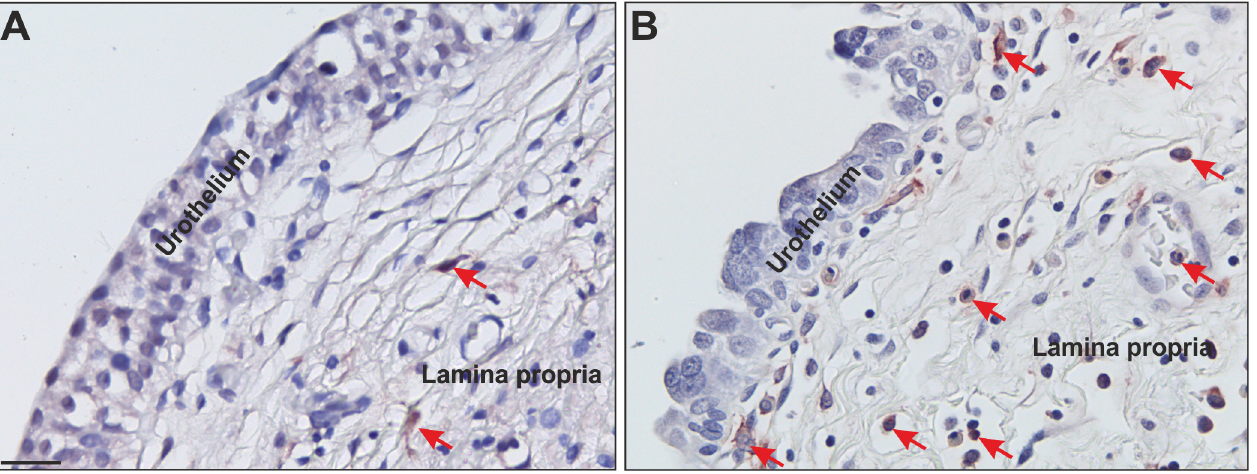
Fig 2. uPAR immunohistochemistry in bladder urothelium with inflammation and CIS, respectively. The figure shows examples of uPAR negative benign-appearing urothelium with inflammation (A) and CIS (B). The tissue section was stained with a pAb against uPAR. The antibody was visualised with NovaRed. The connective tissue (lamina propria) contains leukocytes, of which some few are positive. uPAR positive neutrophils served as internal control ( red arrow). Bar ~ 25 μ m.